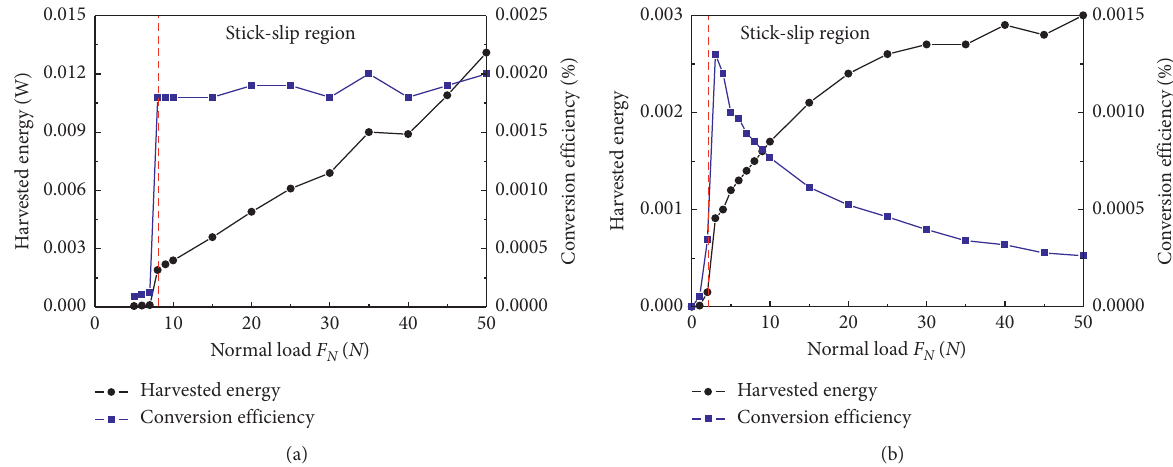
Figure 5: Harvested energy and conversion efficiency of the friction system with different normal loads in the friction laws I (a) and II